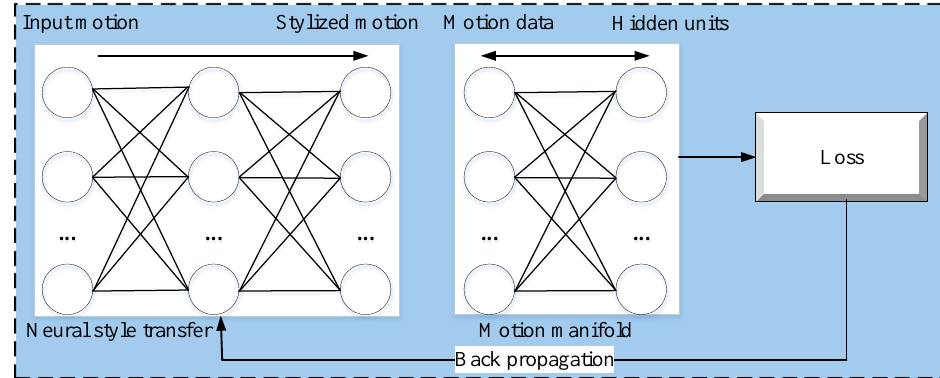
Figure 2. A typical architecture of style transfer from motion-captured